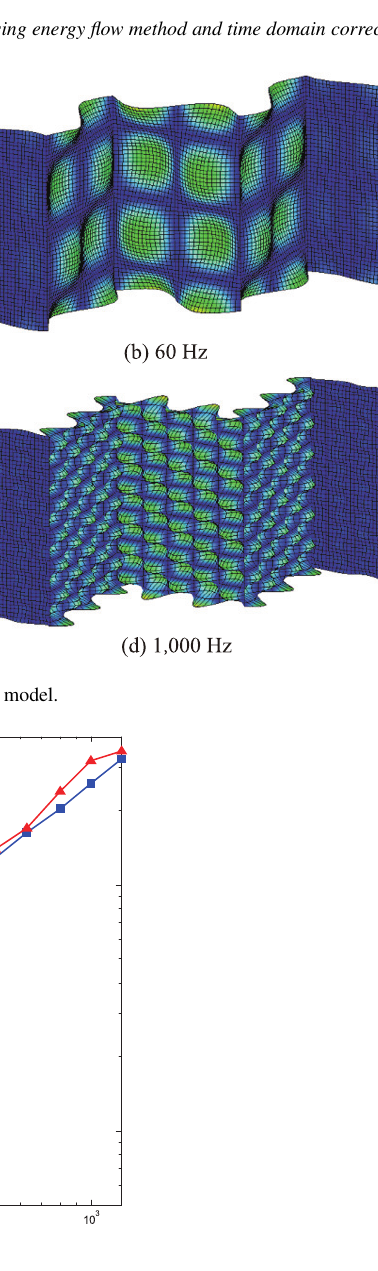
Fig. 8. Modes in band by SEA and